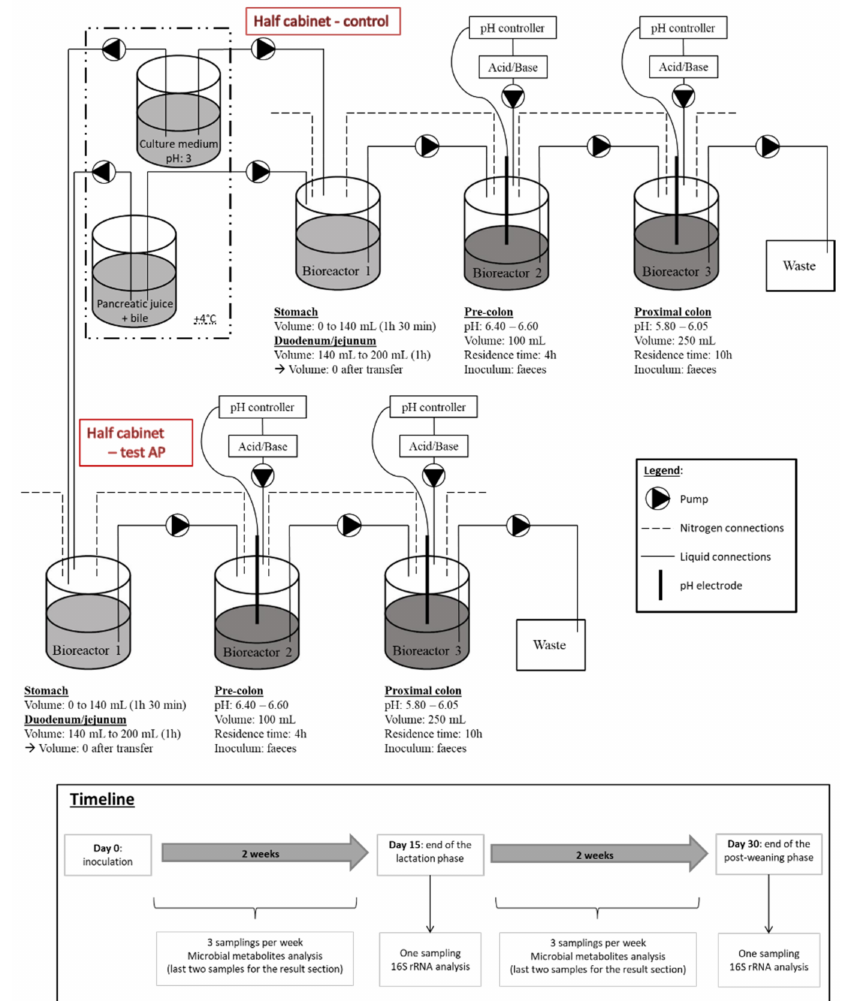
Figure 1. Baby-SPIME model: a SHIME equipment divided into two half cabinets of three double- jacketed bioreactors receiving the culture media three times a day. Bioreactor 1 with medium stomach digestion received pancreatic juice and bile (duodenum/jejunum digestion) following